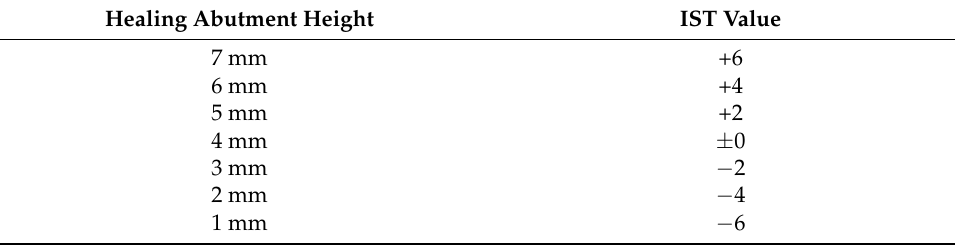
Table 1. Implant stability test value corrections based on the healing abutment height. Healing Abutment Height